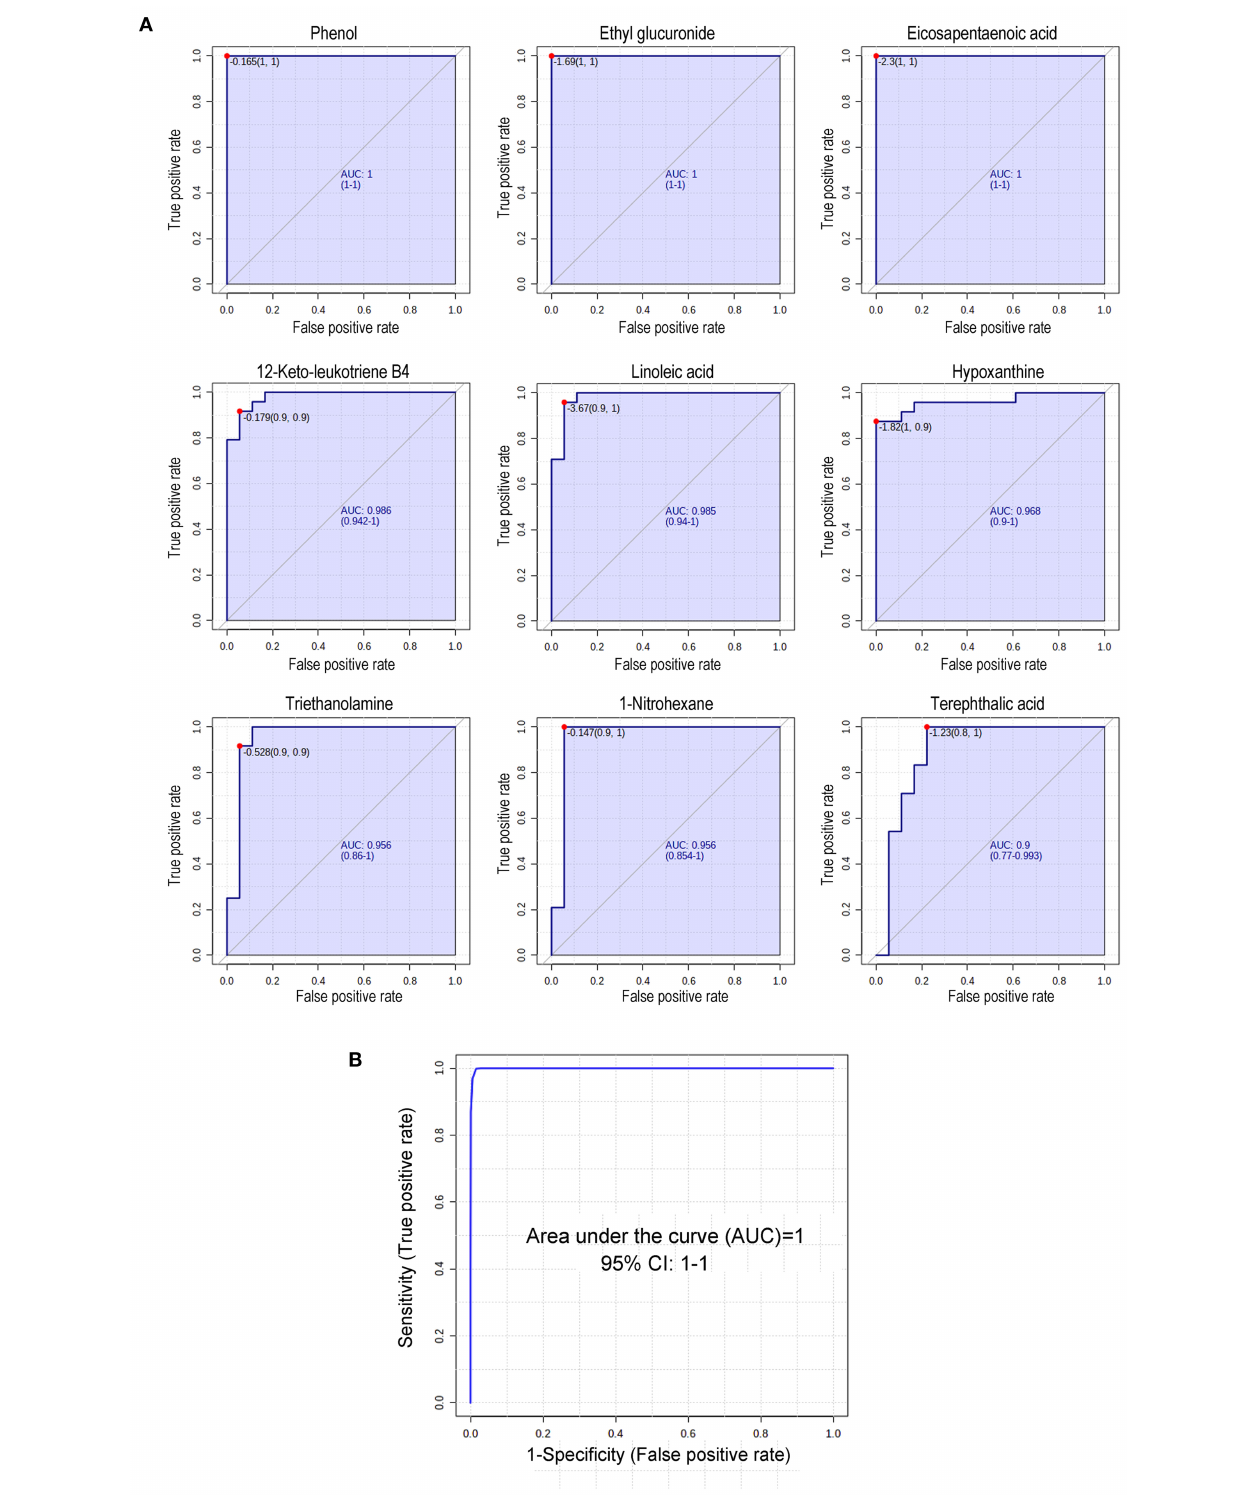
FIGURE 4 | Receiver operating characteristic (ROC) curve analysis of 9 changed metabolites in SLK tear fluids. (A) Diagnostic efficacy evaluation using ROC curves of altered metabolites of tear between SLK and Ctrl individuals. For all 9 metabolites, the AUC ranged from 0.914 to 1 indicating good predictive ability. (B) According to data combining 9 metabolites in (A) , the cumulative ROC curve-based model evaluation (AUC = 1).